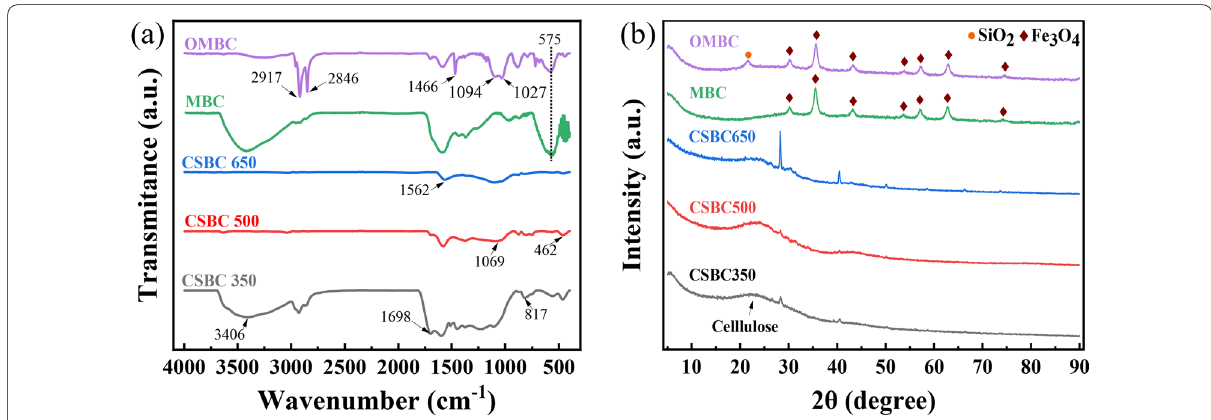
Fig. 4 The FT-IR characterization of the CSBCs and OMBC ( a ). The XRD spectra of CSBCs, MBC, and OMBC ( b